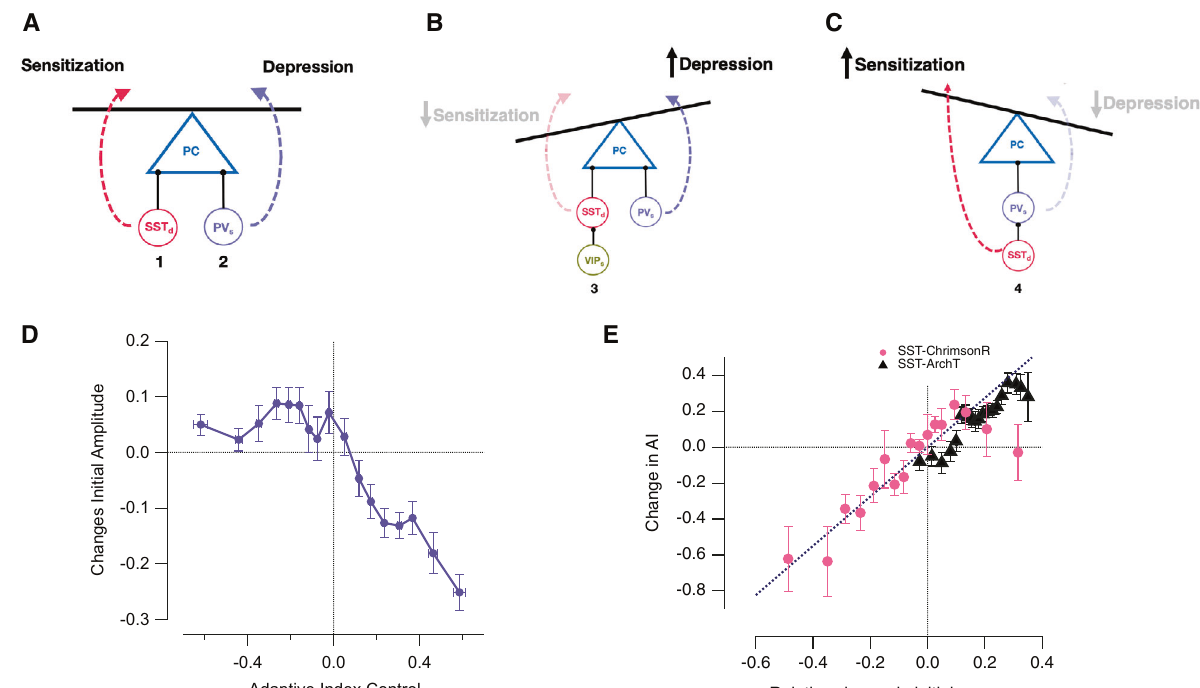
Fig. 8 Local circuits controlling depressing and sensitizing adaptation. A conceptual model consistent with the results in Figs. 1 – 5. The adaptive response in PCs varies because of differences in the balance between direct inputs from SST and PV interneurons. PV s interneurons were sensitizing and therefore drive depression. The majority of SST cells were depressing (denoted SST d ) and drive sensitization. B Activity in VIP interneurons favoured depression (Fig. 6), consistent with reducing the sensitizing input of SST interneurons through the VIP s → SST d disinhibition pathway. C An additional SST → PV s disinhibition circuit is proposed to account for the subset of not responsive PCs with a dramatic increase in gain when activating SSTs (~12%) (Fig. 5G – I). D A test of the model in A focusing on PV interneurons. The plot shows the relation between the change in initial amplitude in PCs upon activation of PV interneurons (measure of direct PV input) and the AI under control conditions. PCs receiving the strongest PV input displayed the strongest depressing adaptation. For sensitizing PCs (AI < 0), PV activation had little effect on the initial amplitude of the response to the high-contrast stimulus, indicating that these received weak PV input. E A test of the model in A focusing on SST interneurons. The plot shows the relation between the change in AI of PCs caused by an optogenetic manipulation and the relative change in initial amplitude of the response (measure of direct SST input). Pink circles show effects of activating SST interneurons using ChrimsonR: the stronger the SST input the stronger the sensitization (Correlation coef fi cient, r = 0.85). Black triangles show effects of inhibiting SST interneurons using ArchT. The greater the increase in gain, the stronger the shift to the depressing mode of adaptation (Correlation coef fi cient, r = 0.93). Dashed line: fi t constrained to pass through the origin. These results support the prediction of the model in A , that PCs with the strongest direct input from SST cells will also have the strongest tendency to sensitize. Data are represented as mean ± SEM of 20 – 30 PCs per point. Source data are provided as a Source Data fi